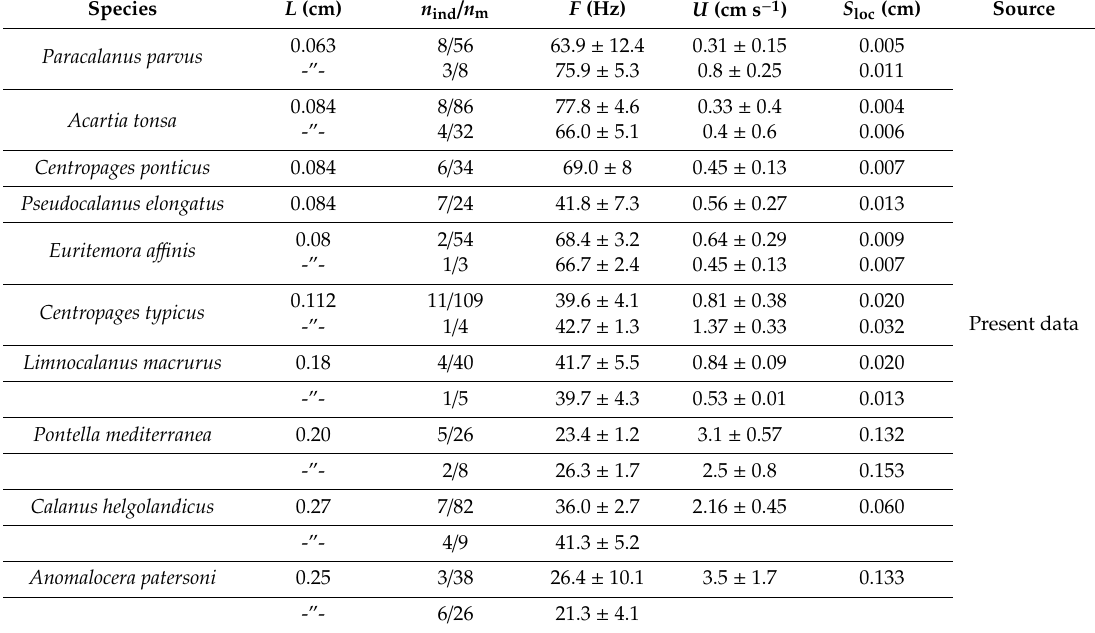
Table 2. Kinematic parameters of cruise swimming calanoid copepods at 20 ◦ C. L pr : prosome length; L an : e ff ective length of second antenna, measured as the distance from body to mid-area of marginal bristles of endopodites; n ind : number of individuals; n m : number of measurements; F : frequency of cephalic appendages at cruising speed; U : horizontal body speed; S loc = U body / F : locomotor